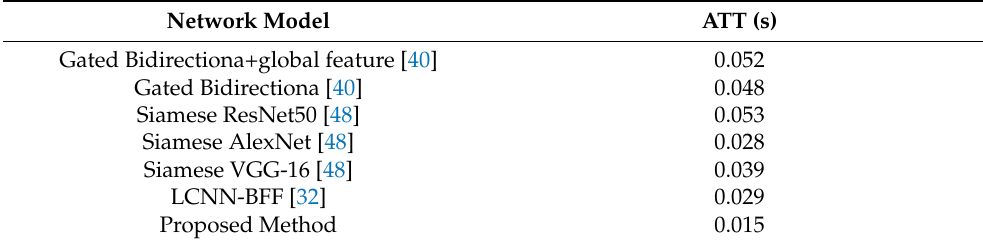
Table 7. Model running speed comparison on UCM